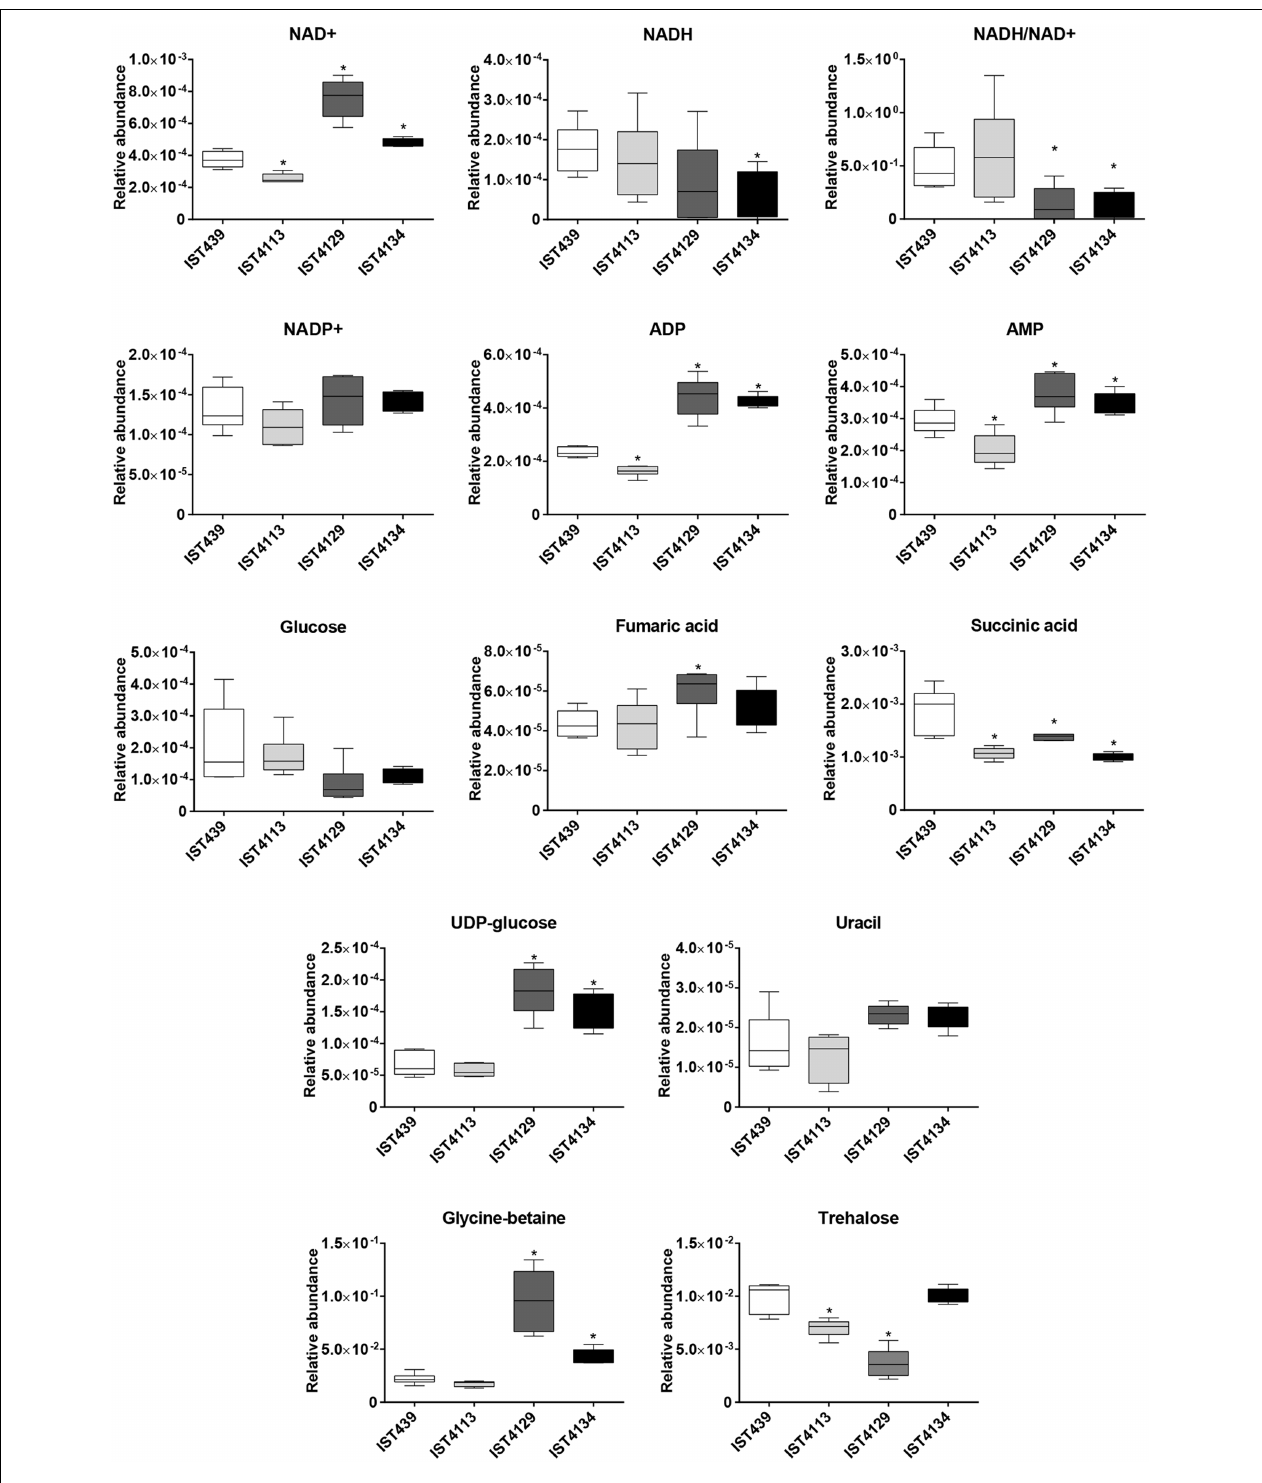
FIGURE 4 | Relative abundance of cofactors, metabolites involved in energy metabolism, organic acids, sugars, uracil and osmolytes, detected through comparative analysis of the endometabolomes of four B. cenocepacia sequential clonal variants retrieved from a CF patient chronically infected for 3.5 years. Each plot shows the variation of the relative abundance of a representative bin in all the spectra for each metabolite and B. cenocepacia isolate. Median values are represented by the line in the middle of the box with the ends showing the 25th and 75th percentiles. Upper and lower ends of the lines represent the maximum and minimum values respectively. ∗ P < 0.05 when each late B. cenocepacia isolate was compared to the first isolate, IST439.